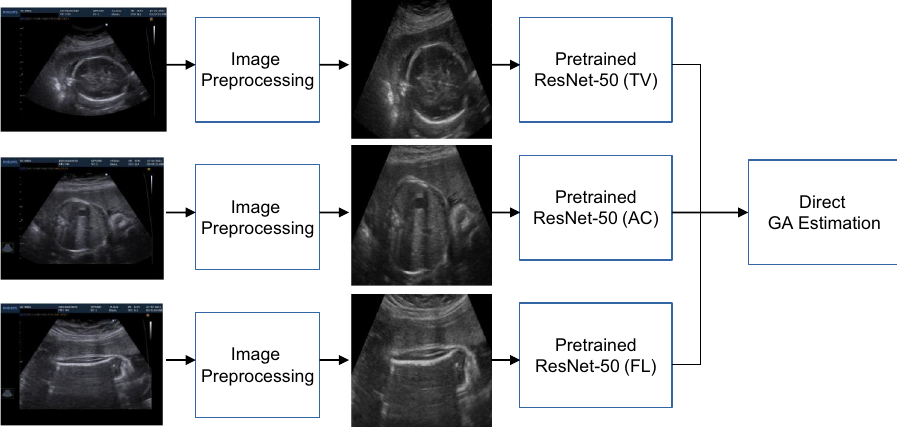
Fig. 6 Training process for MultiPlane model for gestational age estimation. Schematic of training process for multiple ultrasound standard plane-based gestational age (GA) estimation. Pre-trained models are based on single standard plane images trained with Consistent Rank Logit Loss. The fi nal multiple standard plane model is trained with L1-loss. HC Head Circumference; AC Abdominal Circumference; FL Femur Length; GA Gestational